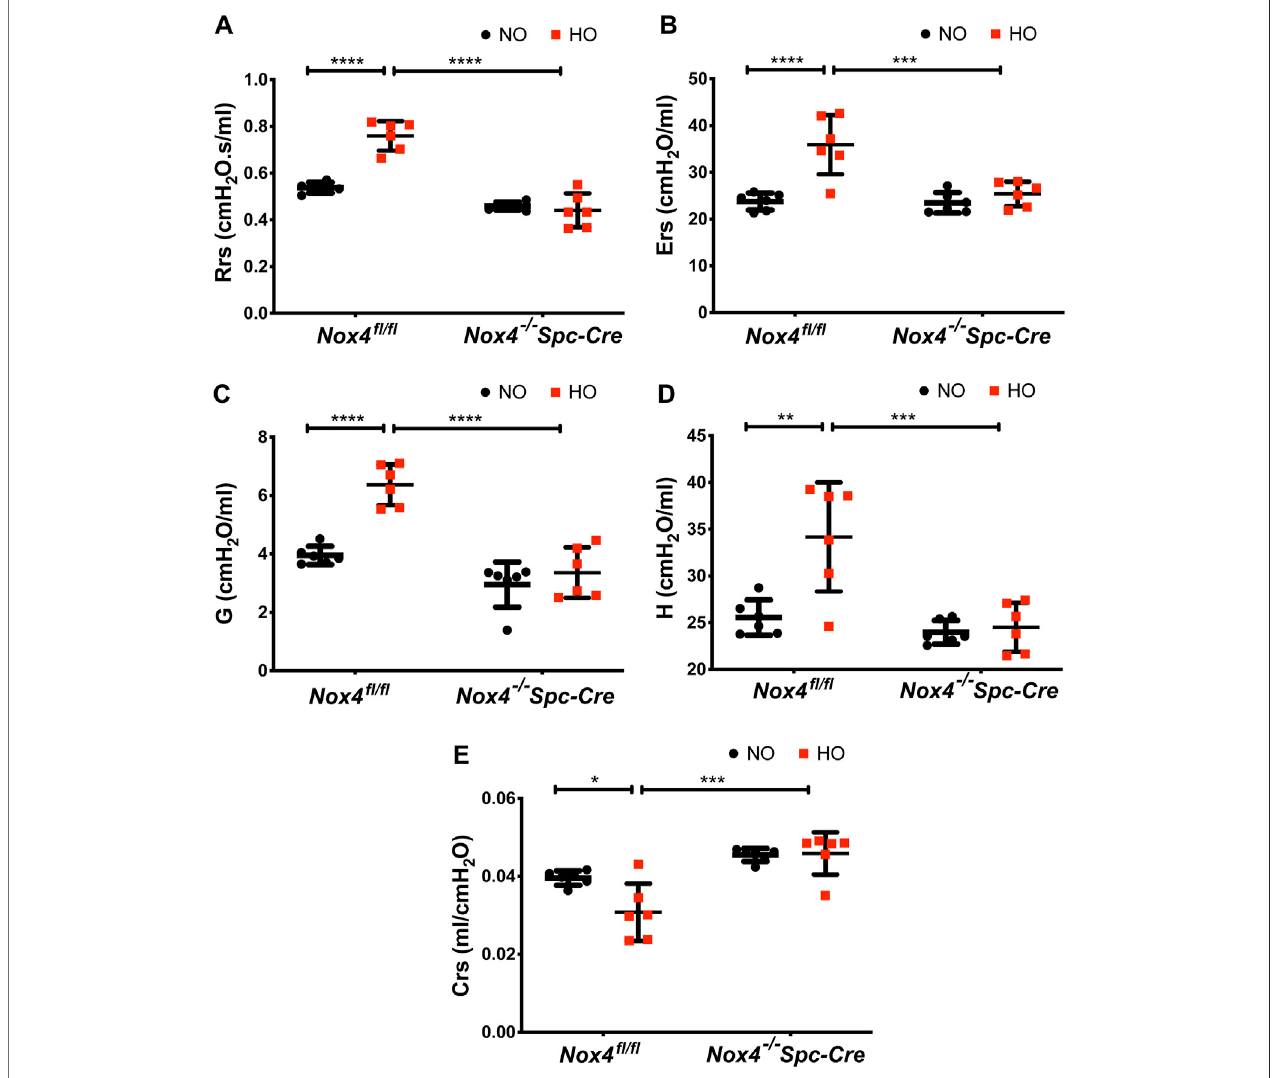
FIGURE 6 | Deletion of Nox4 in AT2 cells prevented the sustained lung injury induced by HO. HO caused an increase in baseline (A) respiratory system resistance (Rrs), (B) respiratorysystemelastance(Ers), (C) tissuedampening/tissueresistance(G), (D) tissueelasticity(H)andadecreasein (E) dynamiccompliance(Crs)following HO in control Nox4 fl / fl mice asmeasuredby forced oscillatory maneuvers on a fl exiVent commercial ventilator. Theseresponses werereduced uponknocking out Nox4 . n = 6. **** p < 0.0001, *** p < 0.001, ** p < 0.01 and * p < 0.05.